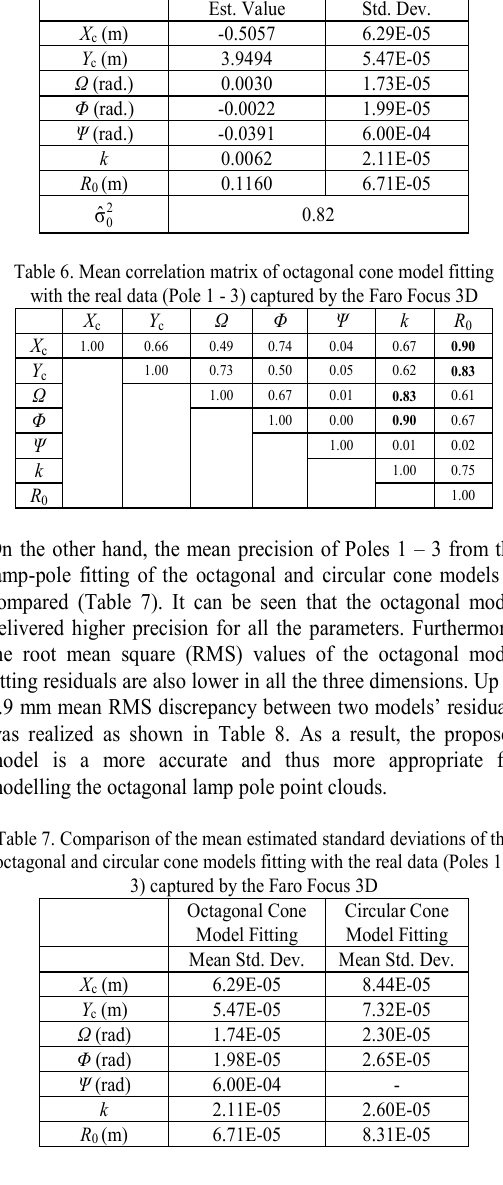
Table 5. Mean estimates of octagonal cone model fitting with the real data (Pole 1 - 3) captured by the Faro Focus 3D